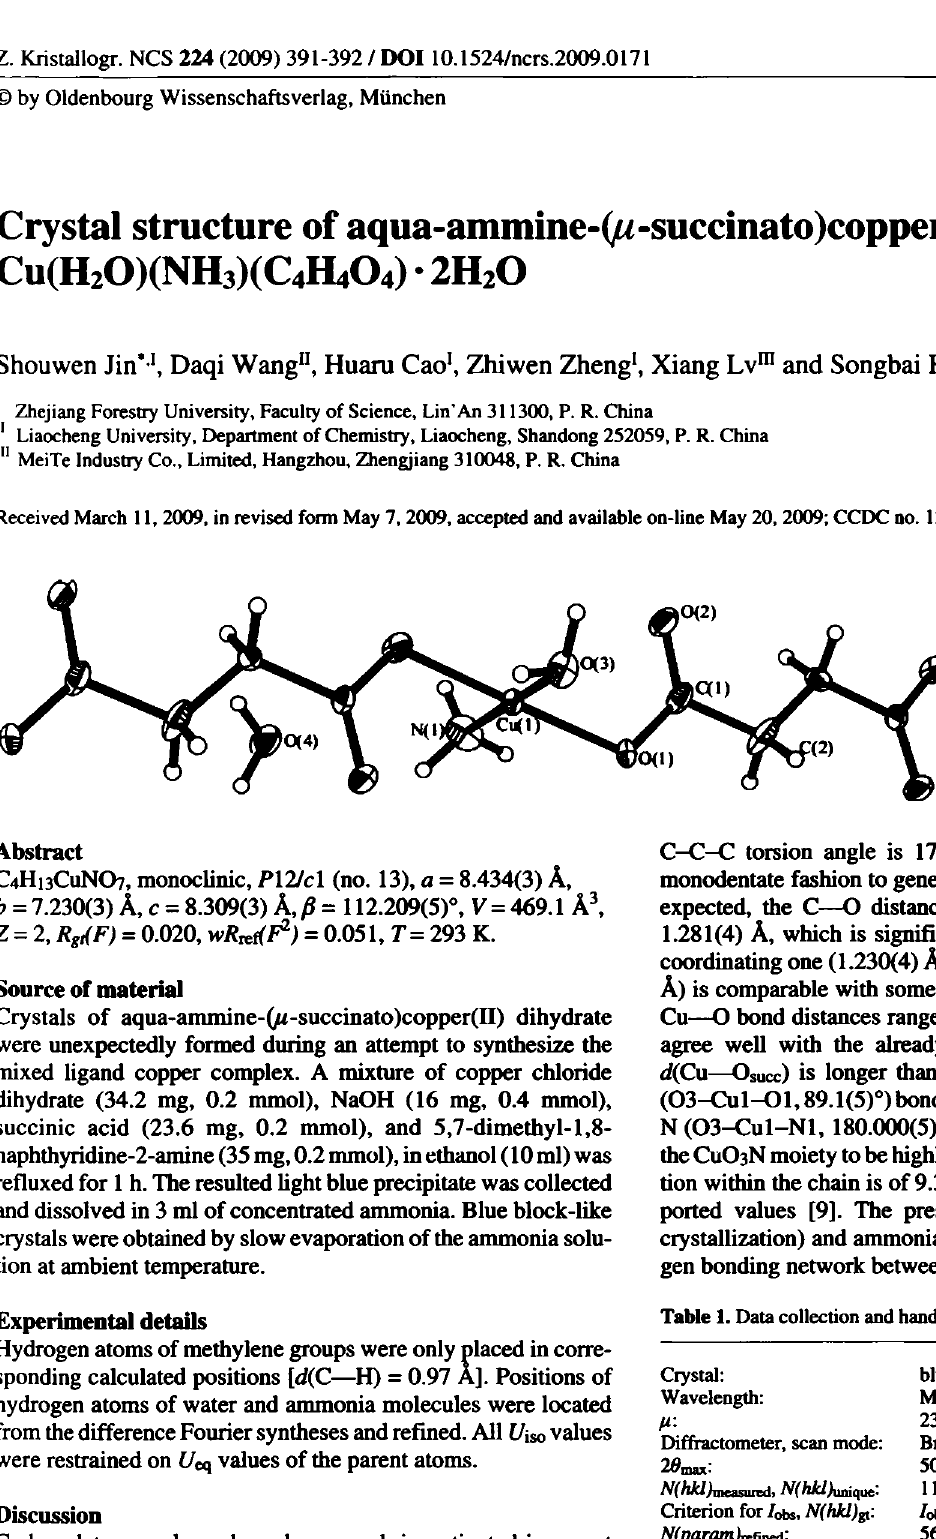
Table 2. Atomic coordinates and displacement parameters (in À 2